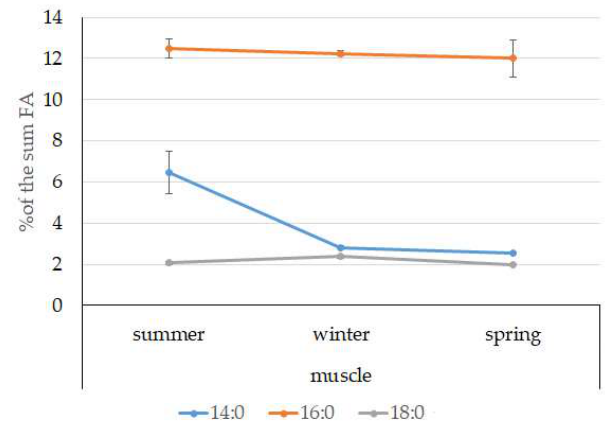
Figure 10. Seasonal dynamic of certain SFA levels (% of the sum of FAs) in muscle in postlarval (L3 developmental stage) daubed shanny from Kongsfjord. The data presented as M ± SE.